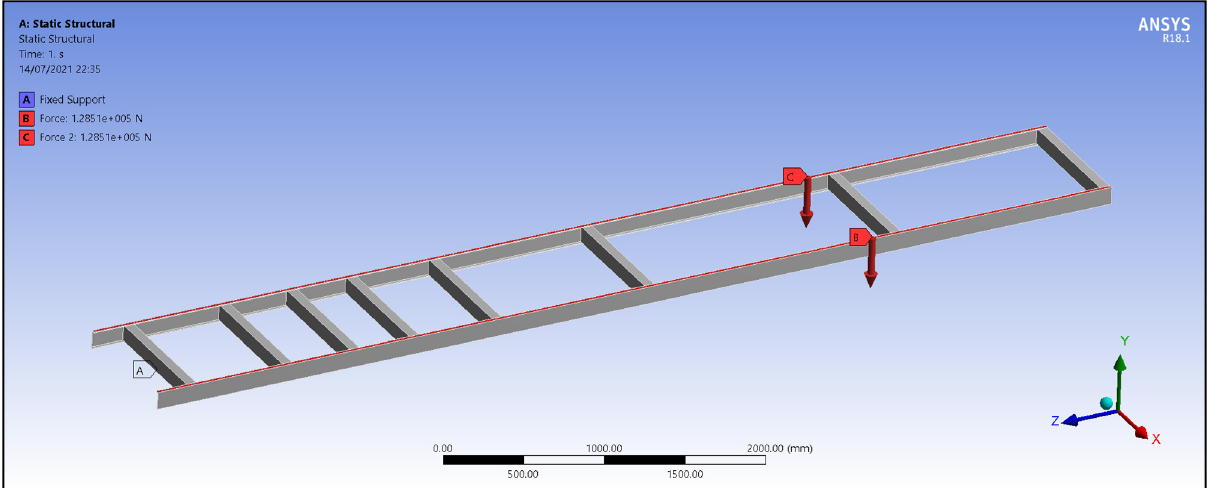
Figure 6. Loads and boundary conditions (Downward force).